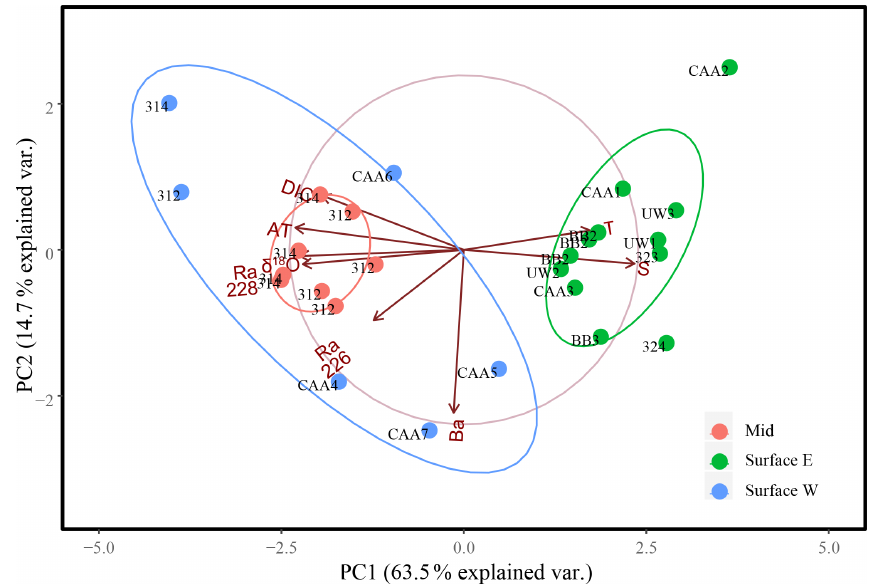
Figure 8. Eight-variable principal component analysis of surface samples (0–20m), east (green, east of 85 ◦ W) and west (blue, west of 85 ◦ W), and mid-depth (20–80m; red) samples collected throughout the Canadian Arctic Archipelago analyzing PC1 and PC2 for 27 samples from 17 stations, with the exception of the surface sample collected at station CB4, which was excluded from this plot. The ellipses represent 95% confidence intervals associated with each water mass